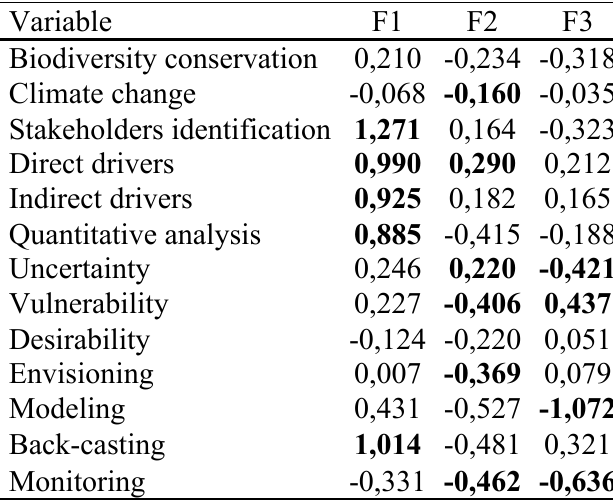
Table A.10.2. Principal coordinates of the variables in the first three axes (F1, F2, F3) of the Multiple Correspondence Analysis (MCA). Values in bold correspond to the variables with highest squared cosines.